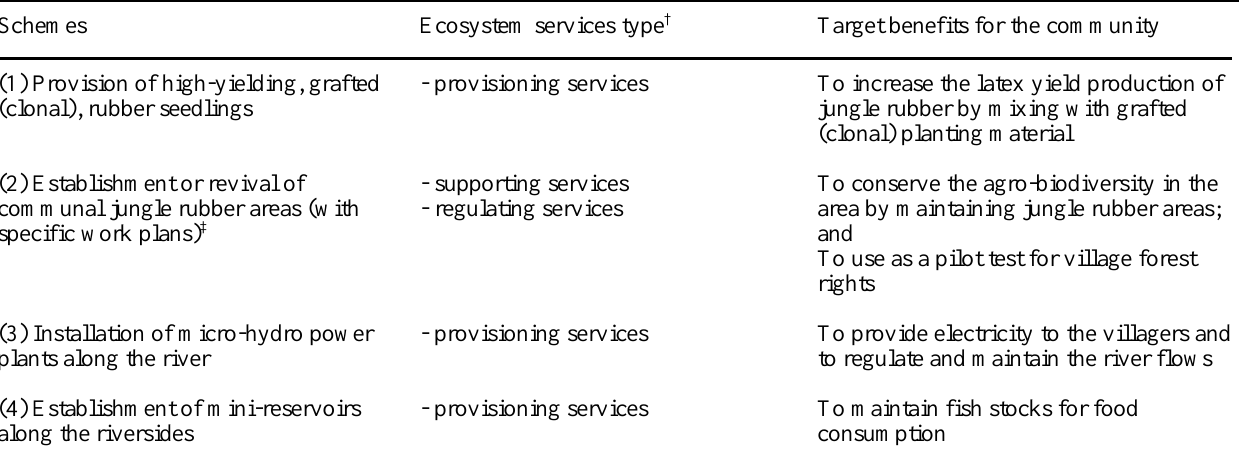
Table 1. Conservation agreement schemes for rubber agroforest conservation Schemes Ecosystem services type † Target benefits for the